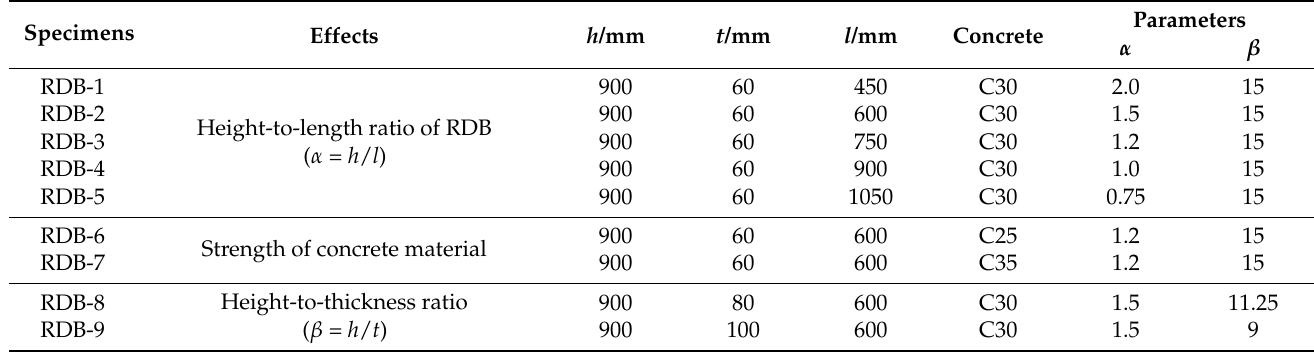
Figure 12. Failure pattern comparison of the tests and FEM predictions. Table 4. Parameters analyzed for